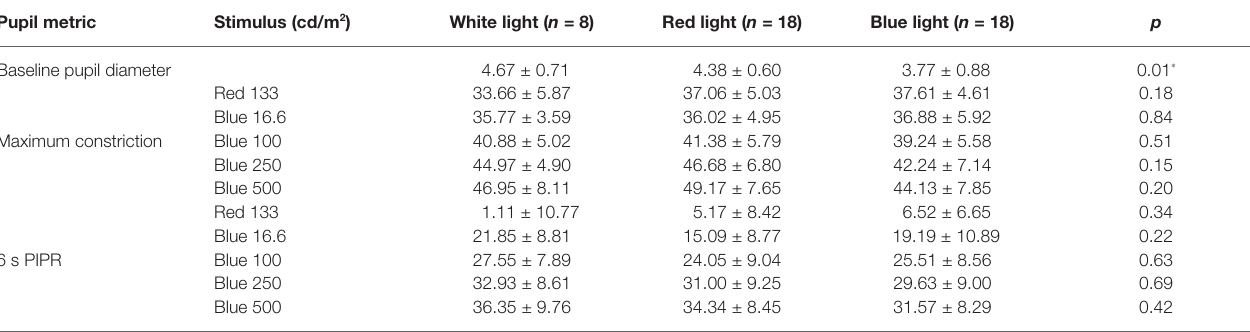
TABLE 4 | Baseline pupil diameter (mm), maximum constriction (% change from baseline), and the 6 s PIPR (% change from baseline) to 1 s red and blue stimuli for white, red, and blue light reared monkeys. Pupil